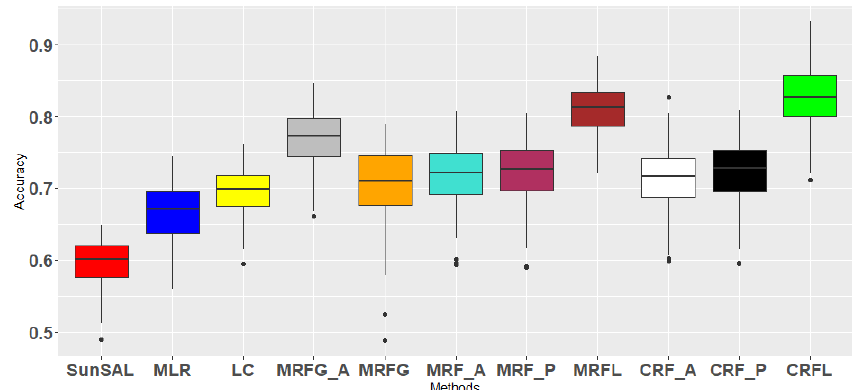
Figure 7. Boxplot from Overall Accuracies (OA) for several methods on the University of Pavia image, including the proposed ones: MRFL and CRFL (100 experiments).